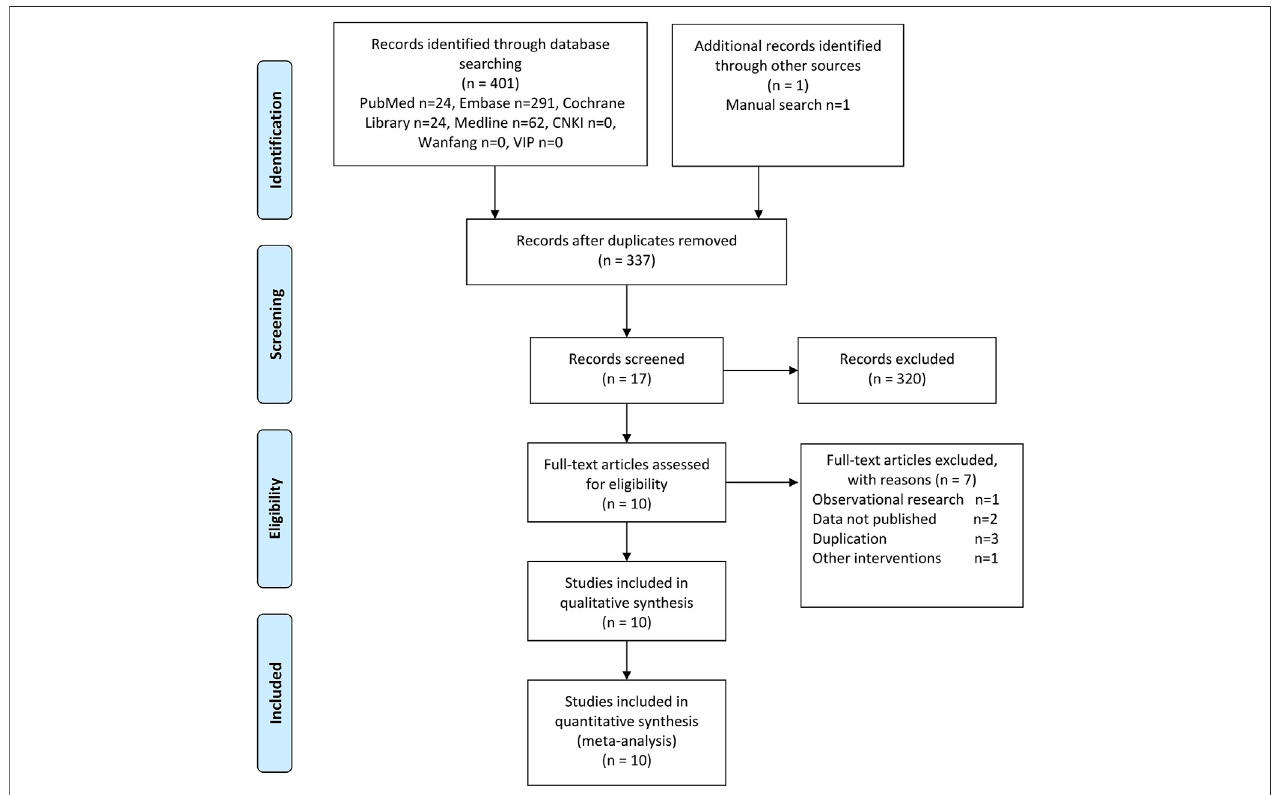
FIGURE 1 | PRISMA fl ow